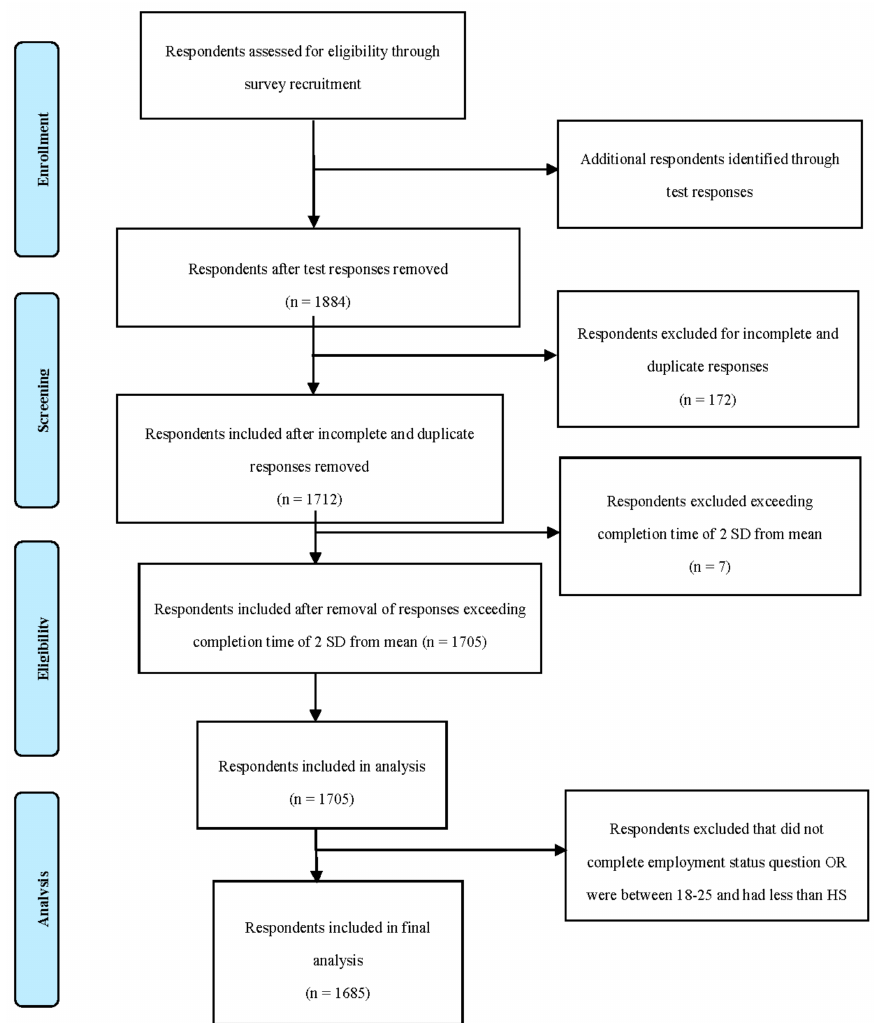
Figure 2. Participant flow